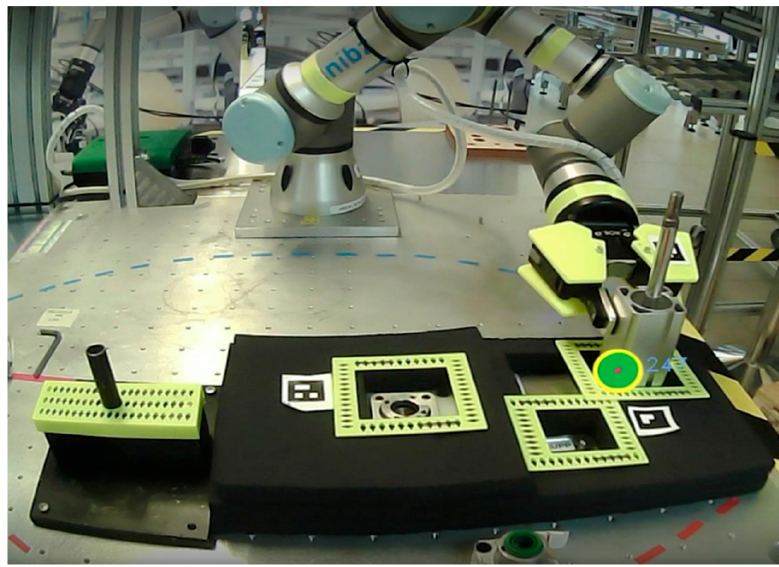
Figure 1. Workstation structure and components.